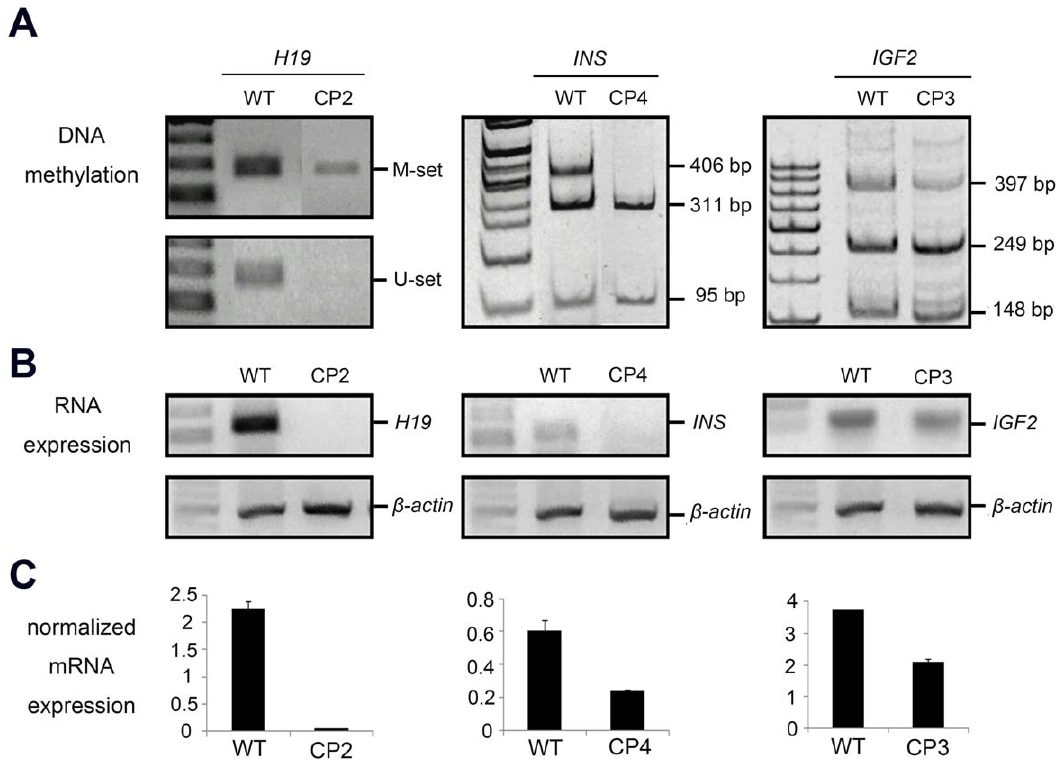
Figure 6. The aberrant methylation of the H19 , INS and IGF2 genes and their mRNA expression levels in cloned pigs. (A) DNA methylation statuses of H19 , INS , and IGF2 in CP2 ear, CP4 ear, and CP3 ear, respectively. (B) mRNA expression levels of H19 , INS and IGF2 gene in CP2 ear, CP4 ear, and CP3 ear, respectively. (C) mRNA levels from panel B relative to b -actin . doi:10.1371/journal.pone.0032812.g006 PLoS ONE |